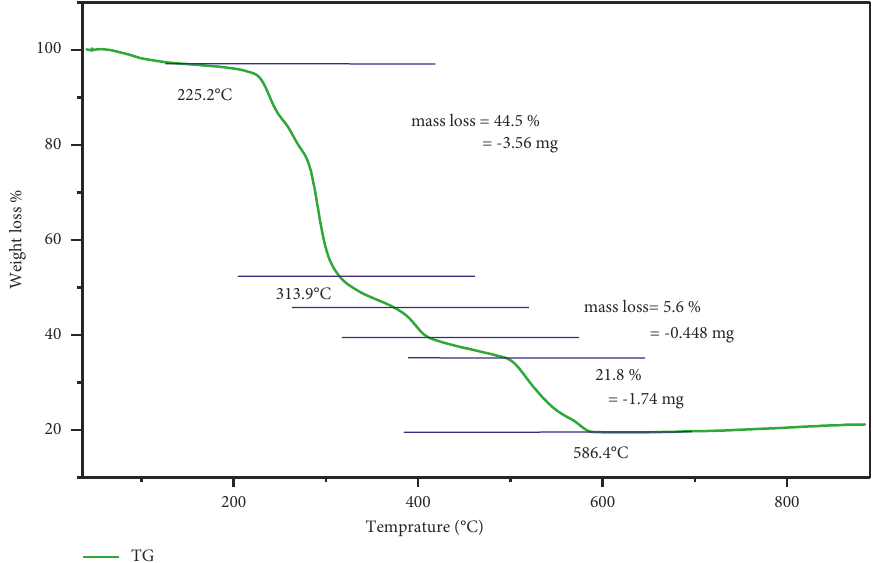
Figure 12: Thermogram curve of [Cu( L